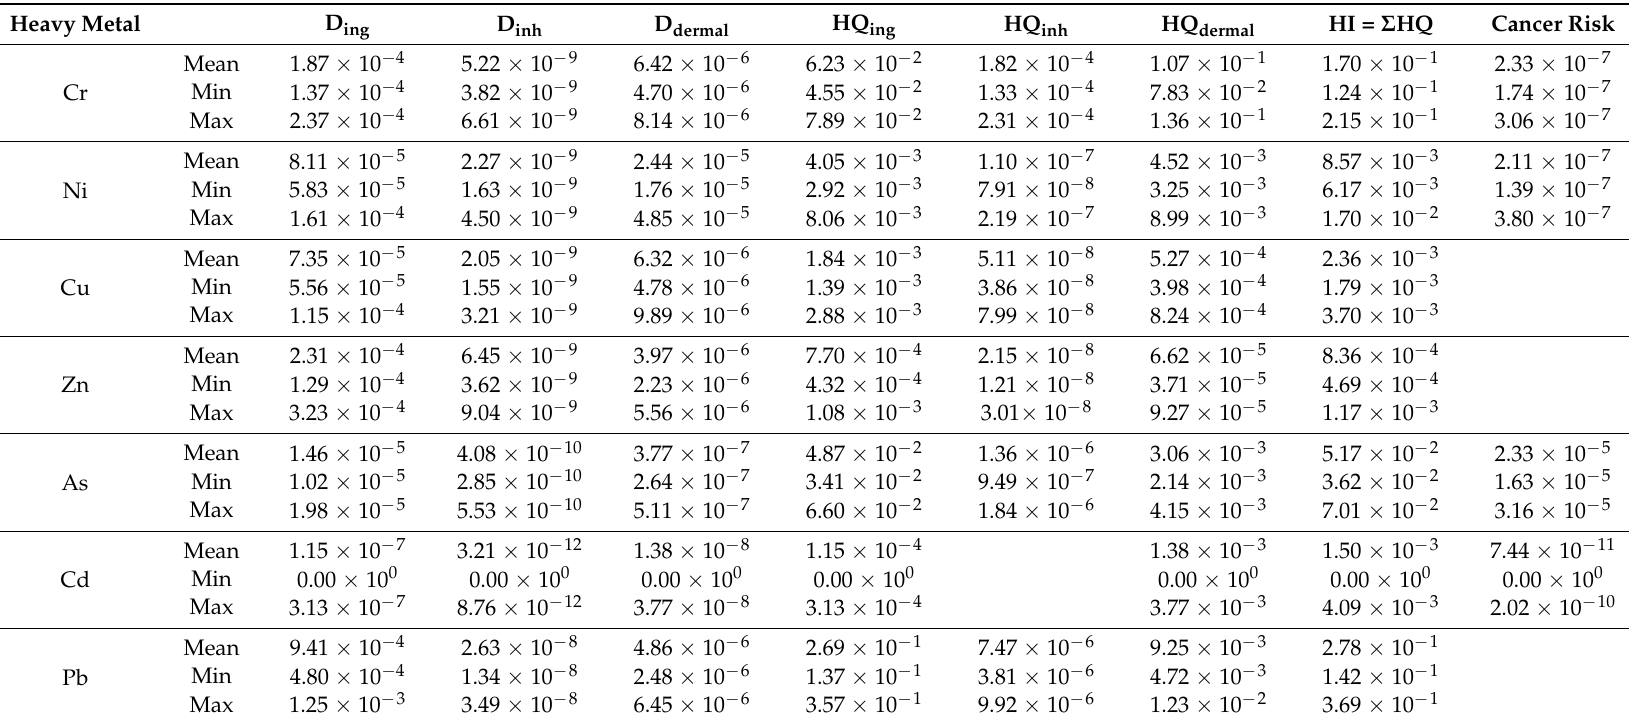
Table 4. Daily doses, hazard quotients, hazard indices, and cancer risks of heavy metals for children. Heavy